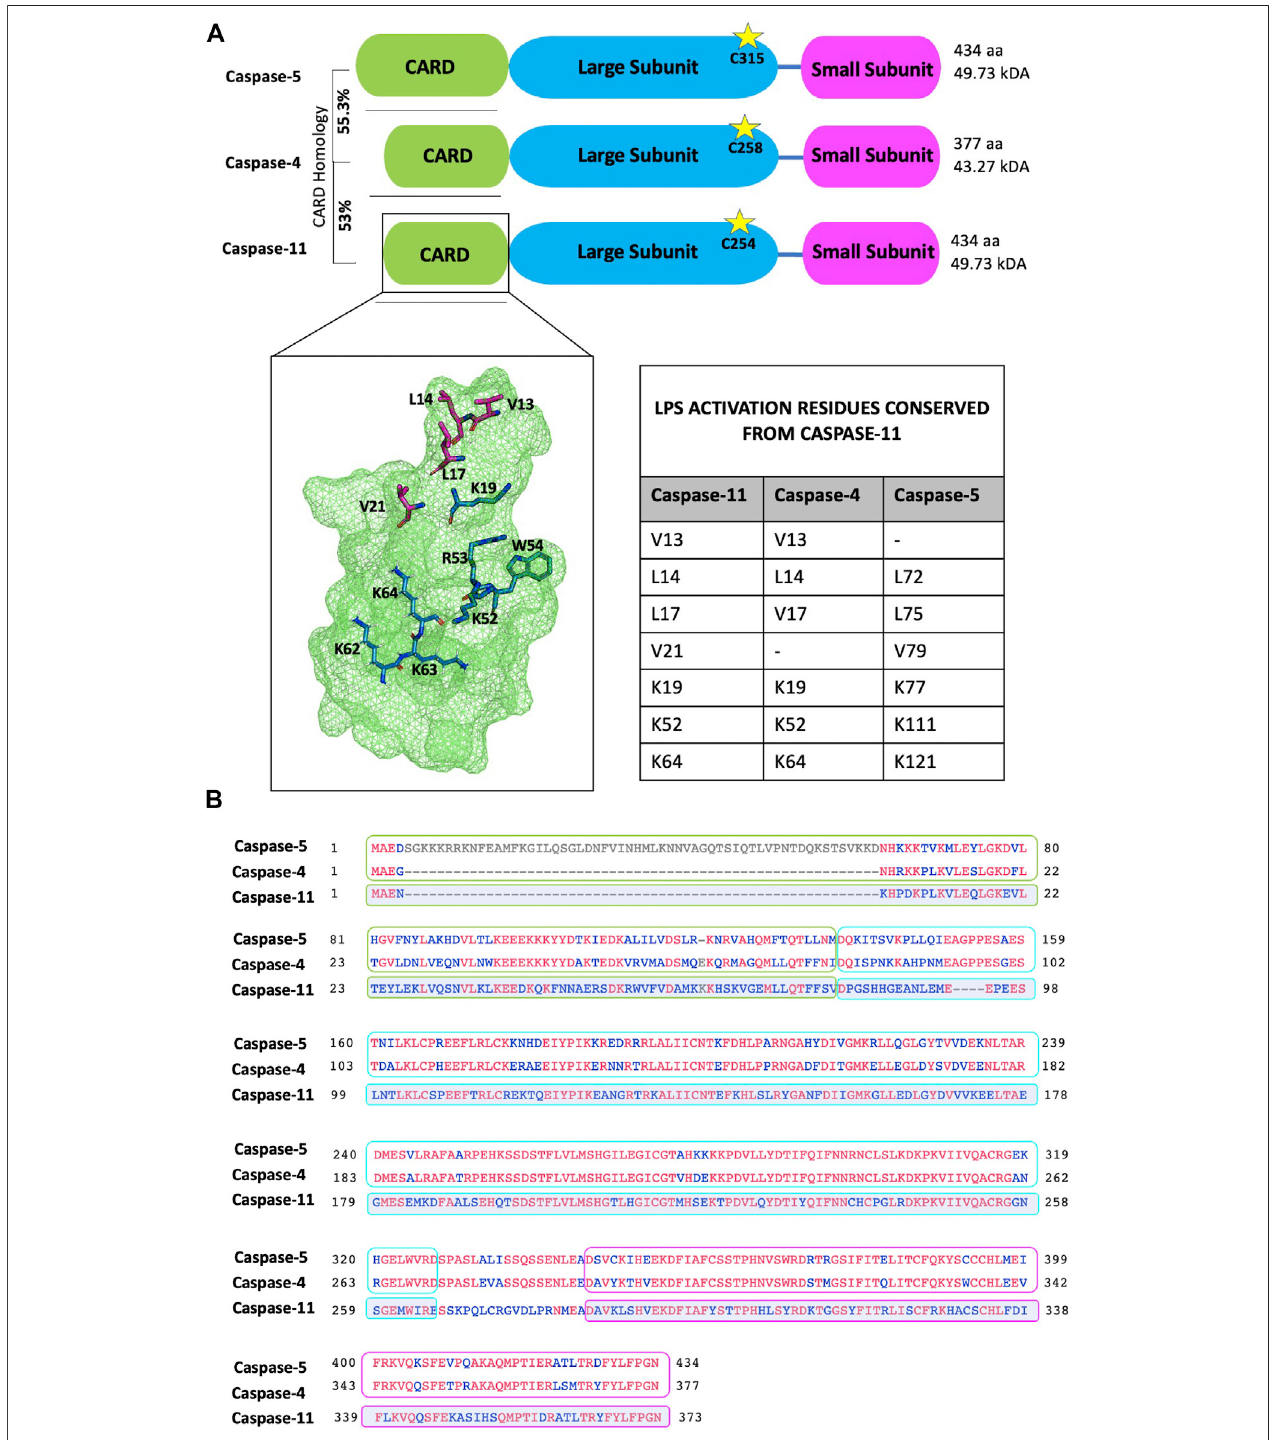
FIGURE 3 | Protein domain and sequence alignments of the non-canonical caspases. (A) Schematic representation of caspases-4, -5 and -11. Cleavage is dependent on the conserved catalytic cysteine residue (indicated by stars). The caspase-5 N-terminal pro-domain contains an additional 58 amino acids and shares 55.3% homology with the caspase-4 pro-domain. Similarly, the caspase-4 pro-domain shares 53% homology with the caspase-11 pro-domain. Zymogen cleavage separates the CARD domain (green box), the large subunit (blue box) and the small subunit (pink box). The small and large subunits form the enzymatically active heterodimer. Crystal structure of the caspase-11 CARD highlights residues important for activation: LPS binding (blue) and oligomerisation (magenta). Residues 62-64 are modelled as they are not represented in the crystal structure. Activation residues from caspase-11 that are conserved in caspases-4 and -5 are listed in the table